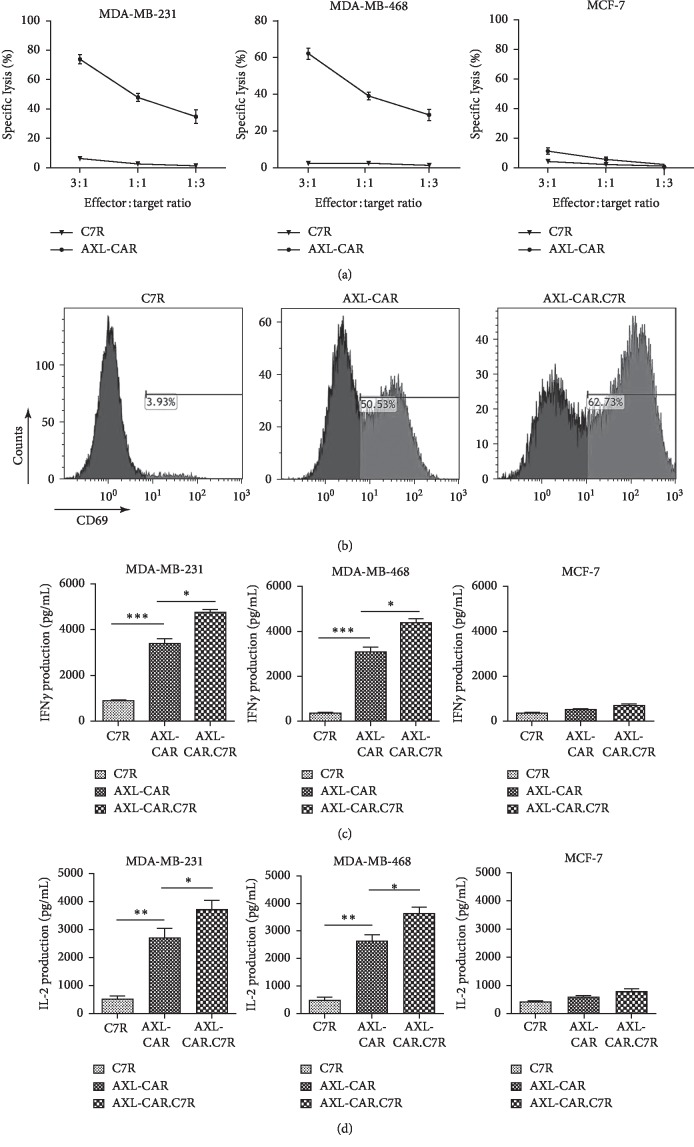
The effect of C7R on the activation of AXL-CAR-T cells. (a) Determination of the optimal target ratio. A total of 1 × 104 target cells were incubated with T cells at different ratios. The concentrations of LDH released in the supernatant were measured 24 hours later. (b) A total of 1 × 104 target cells were incubated with T cells for 24 h at a ratio of 2 : 1. The expression level of CD69 in T cells was measured by flow cytometry. (c) A total of 1 × 104 target cells were incubated with T cells for 24 h at a ratio of 2 : 1, levels of IL-2 secretion were measured (n = 3, ∗P < 0.05, ∗∗P < 0.01). (d) The concentrations of secreted IFNγ (n = 3, ∗P < 0.05, ∗∗P < 0.01).